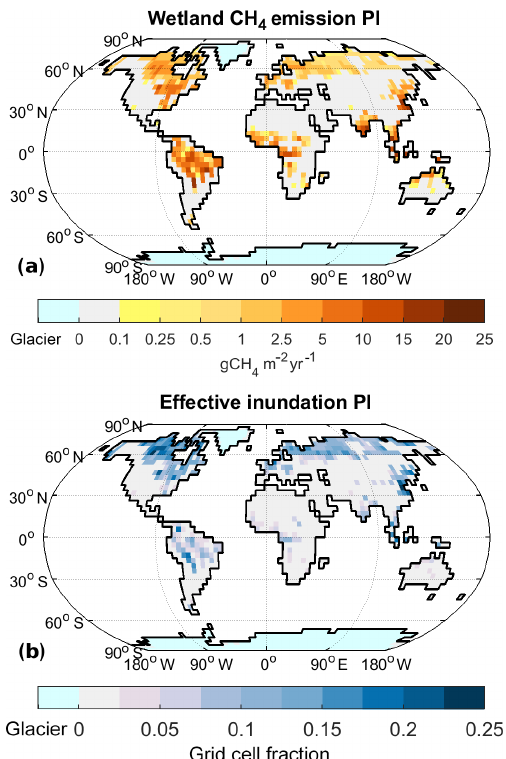
Figure 4. Wetland CH 4 emissions for preindustrial (PI) climate: annual emissions of CH 4 from wetlands (a) and effective inunda- tion (b)